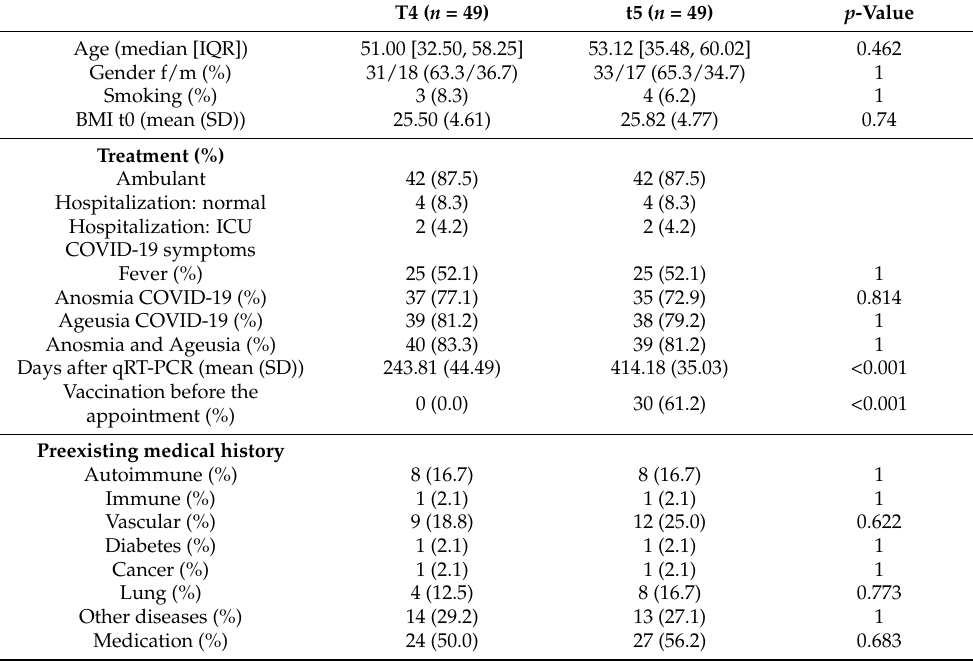
Table 2. Comparison of COVID-19 recovered subjects 6 and 12 months after study inclusion (all V1